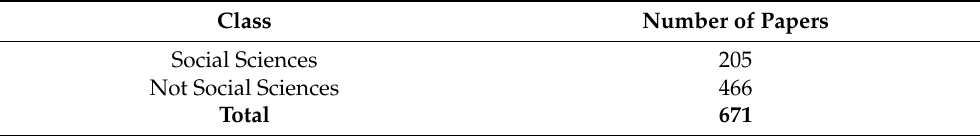
Table 2. Social sciences versus non-social sciences in our